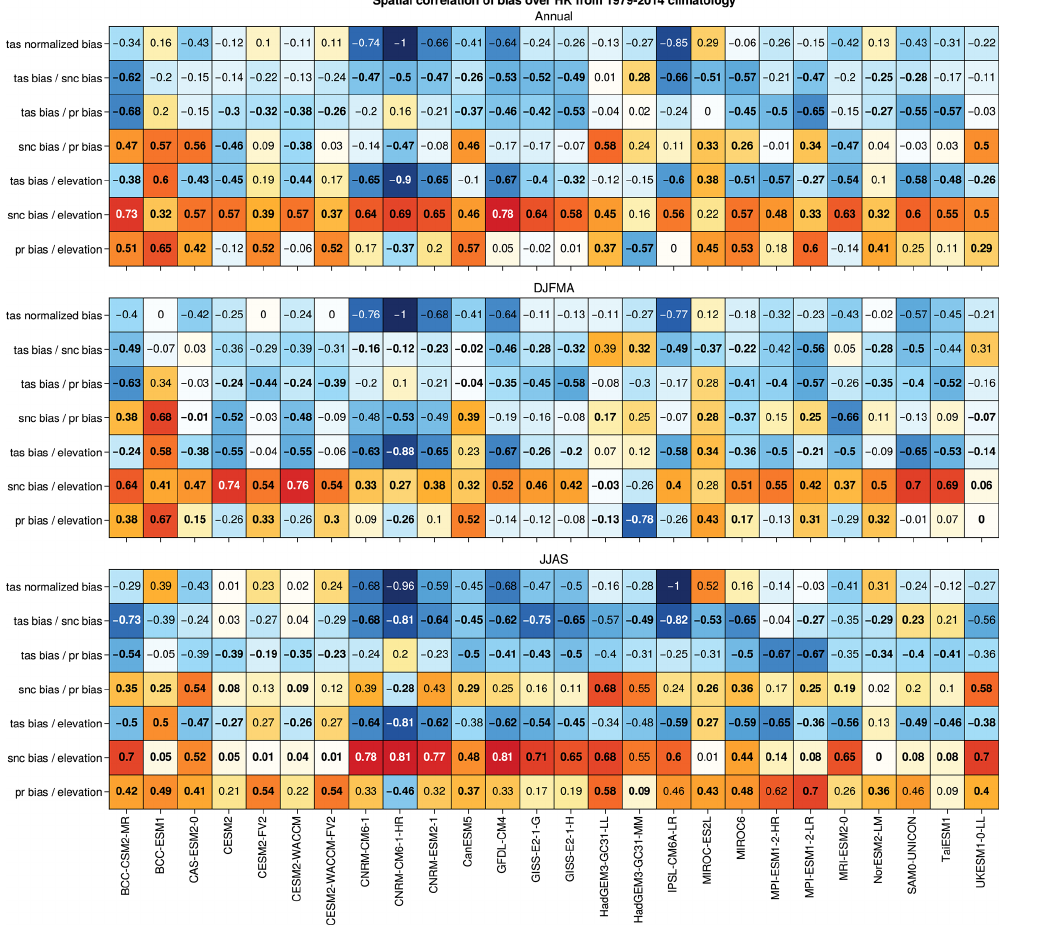
Figure C2. Same as Fig. 4 but for HK regional and seasonal